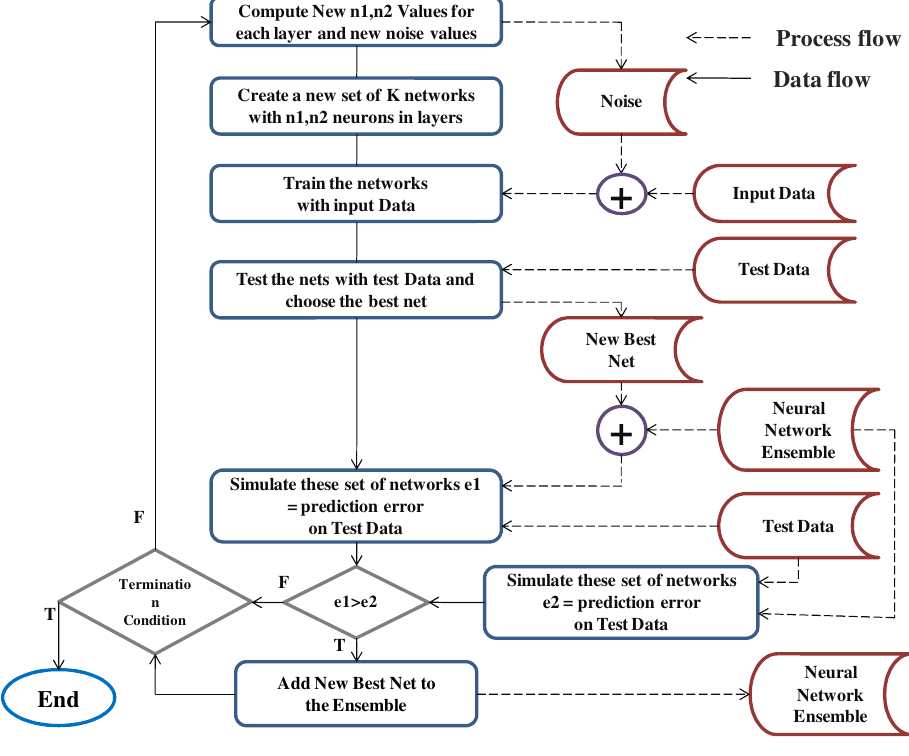
Fig. (7). Learning Phase Process for Ensemble Neural network Fig. 7. Learning phase process for ensemble neural